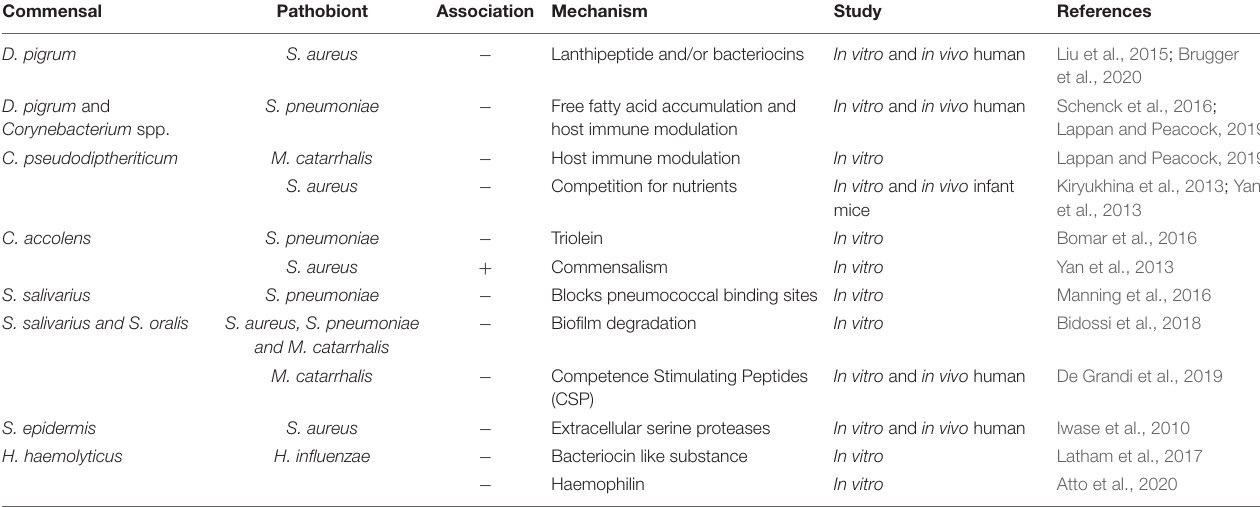
TABLE 1 | Association between commensal bacteria and bacterial pathobionts in the